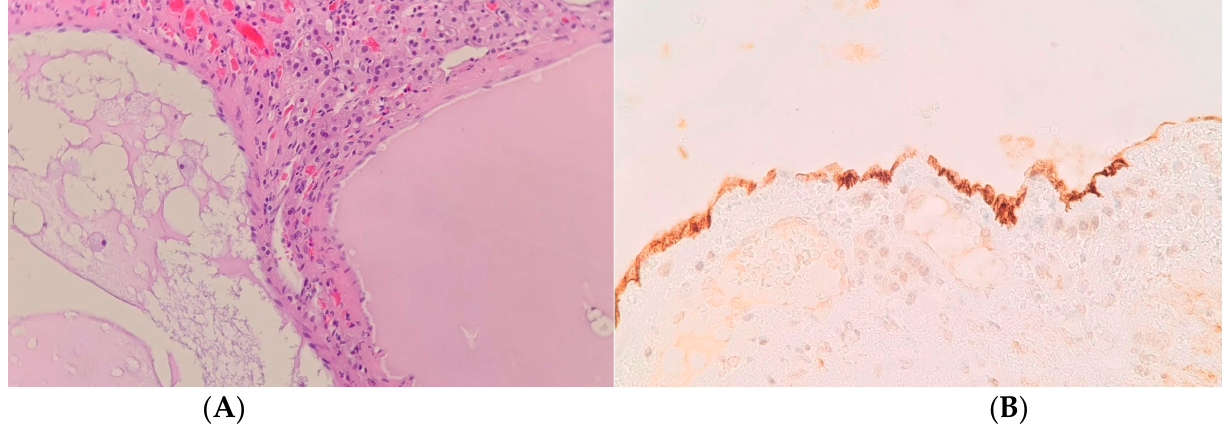
Figure 9. Adrenal lymphangioma—the tumor adjoins the adrenal cortex and consists of numerous cysts filled with proteinaceous content (( A ), hematoxylin and eosin, 100× magnification), and lined with podoplanin-expressing lymphatic endothelium. Immunohistochemistry for podoplanin, 400× magnification ( B ).